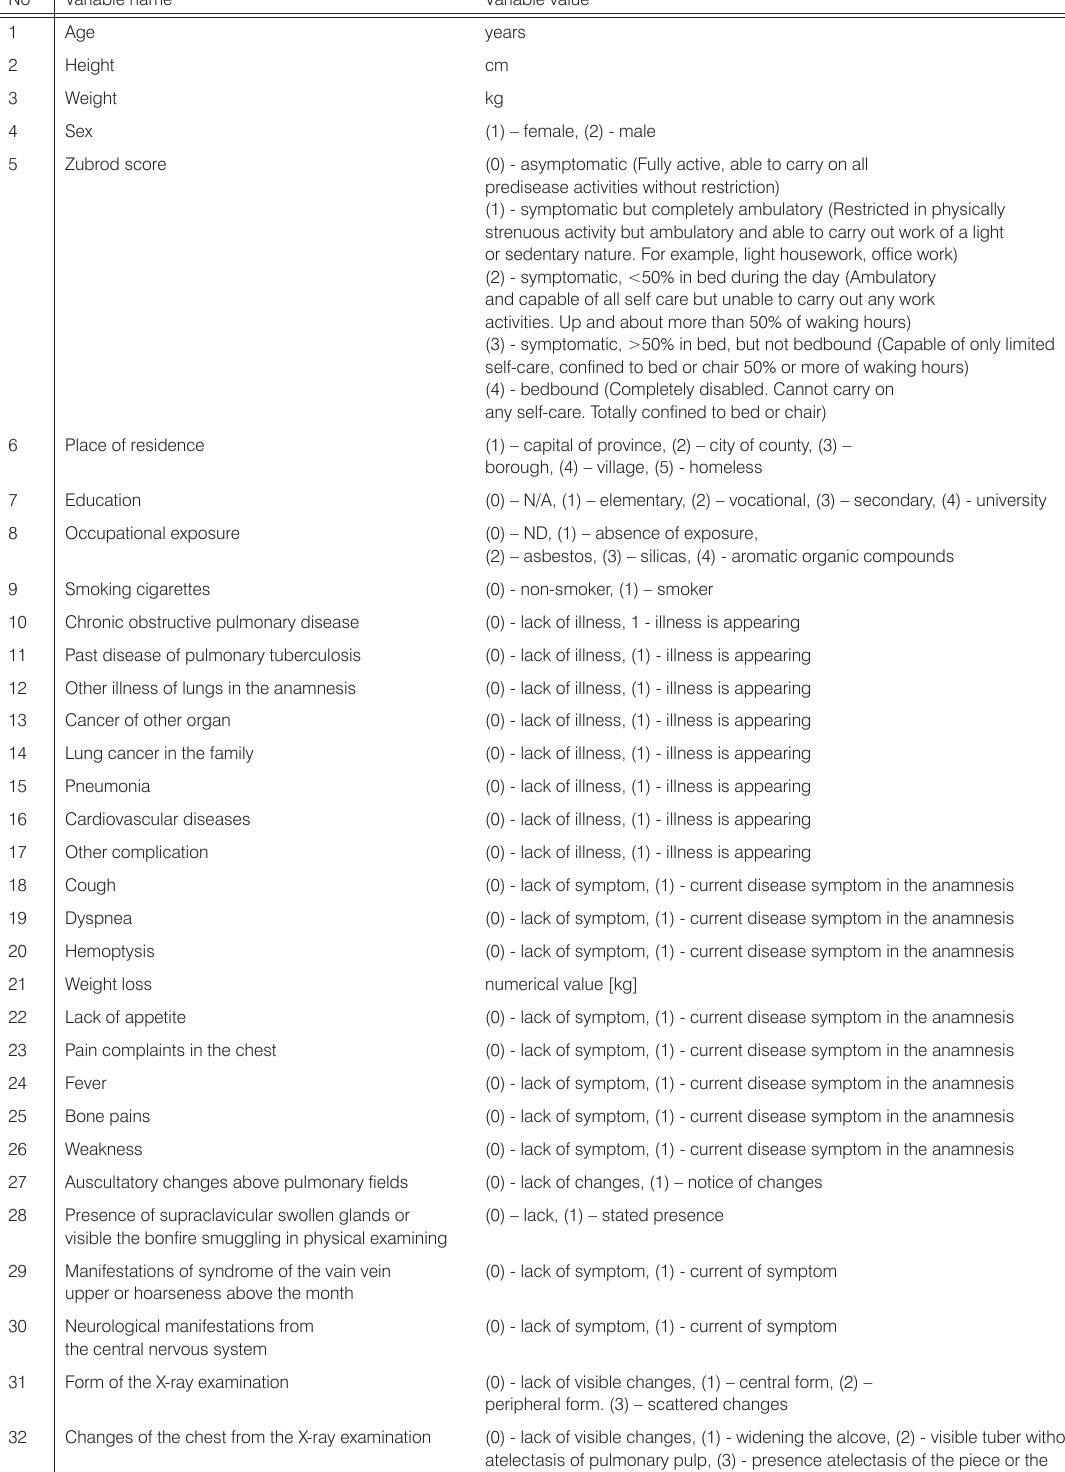
Table 1. Variables considered in the ANN